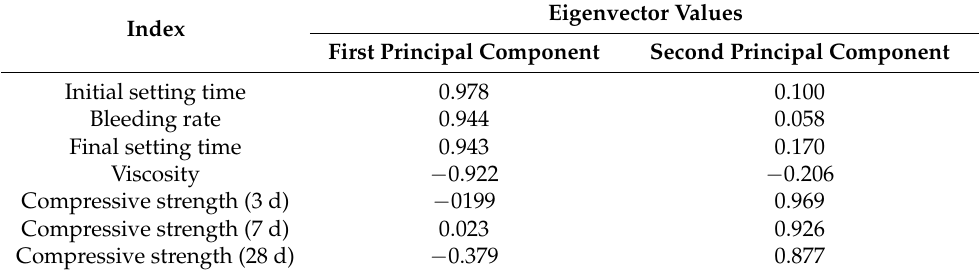
Table 9. Principal component score and standardized comprehensive score.